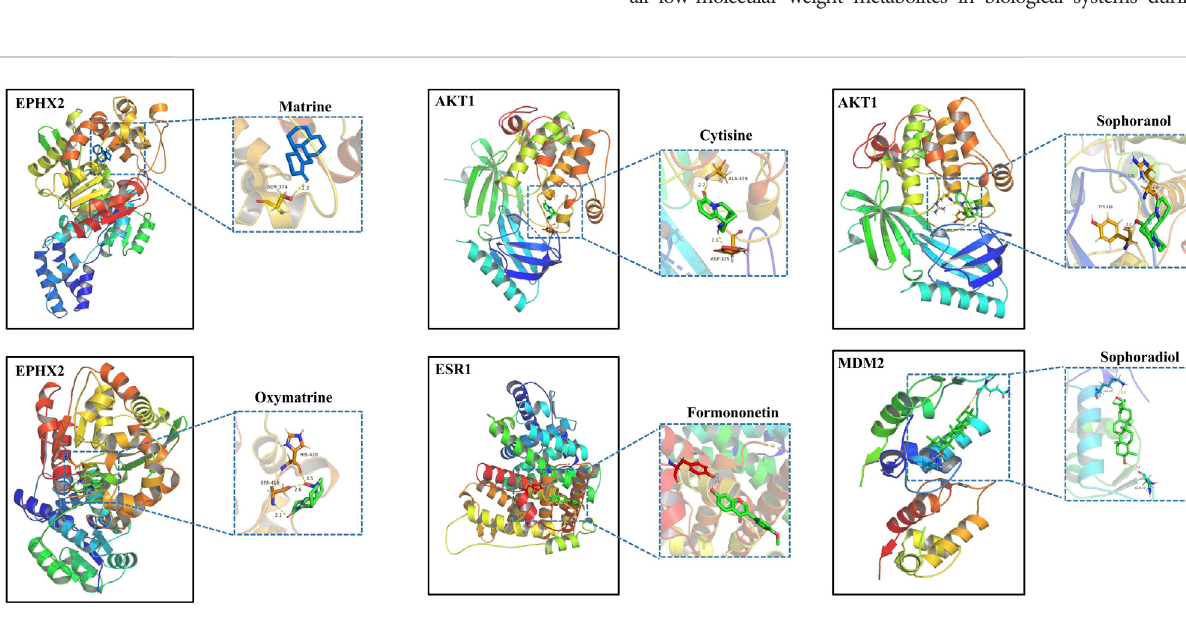
FIGURE 5 The 3D interaction diagrams of MT, OMT, cytisine, sophoranol, formononetin and sophoradiol with related key targets.